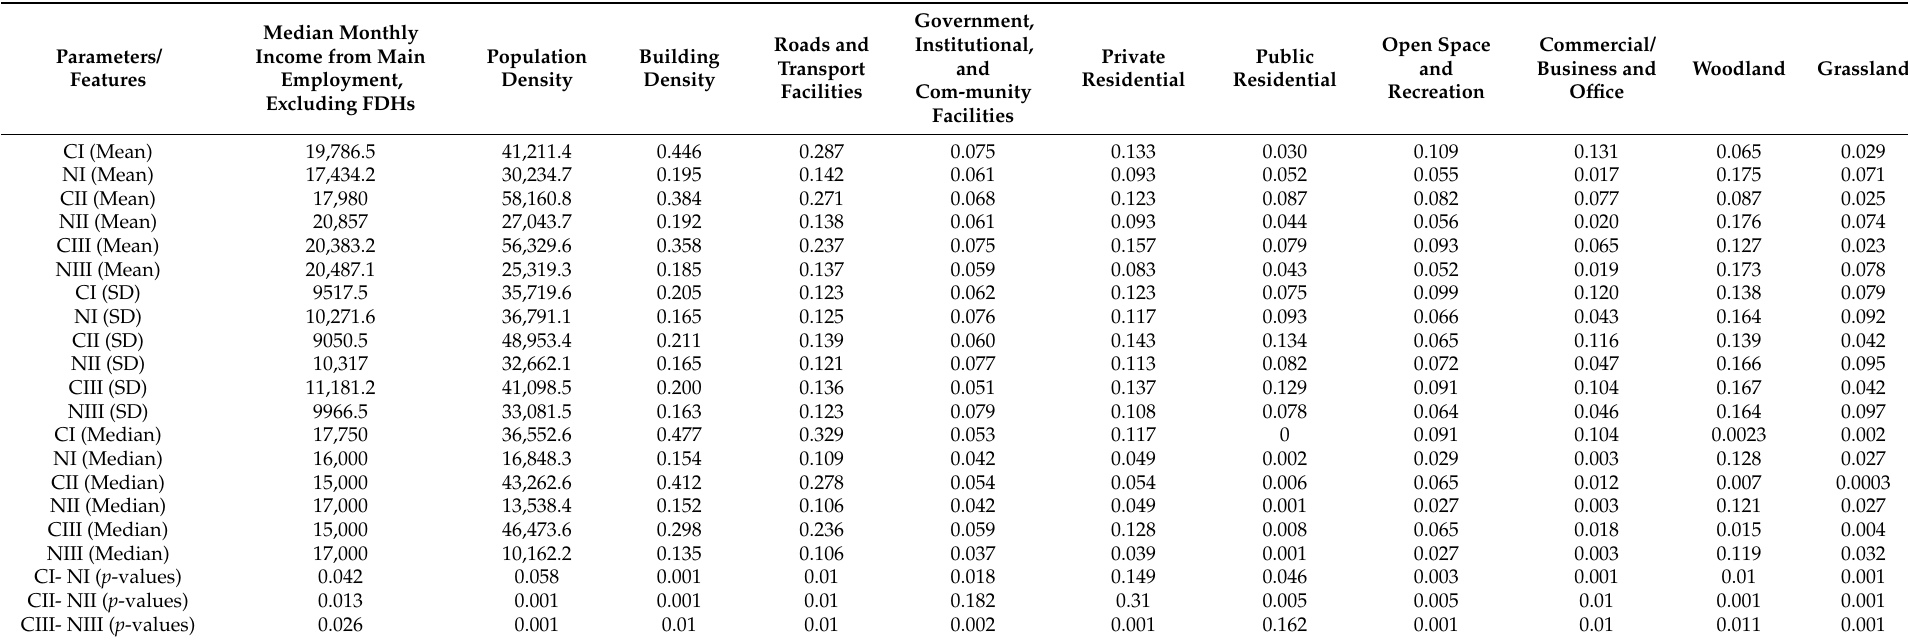
Table 10. Features’ distribution at different stages of non-residential location (“ p -value” is performed as asymptotic two-tailed significance of the Mann–Whitney test).